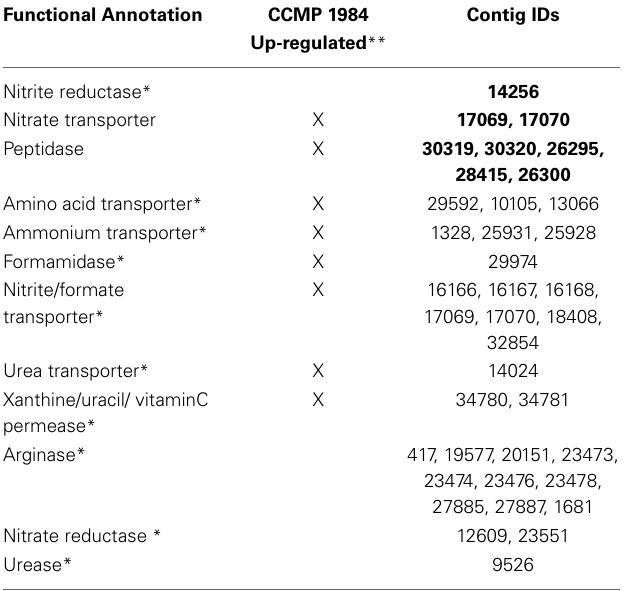
Table 5 | The N-related transcripts discussed in this study.